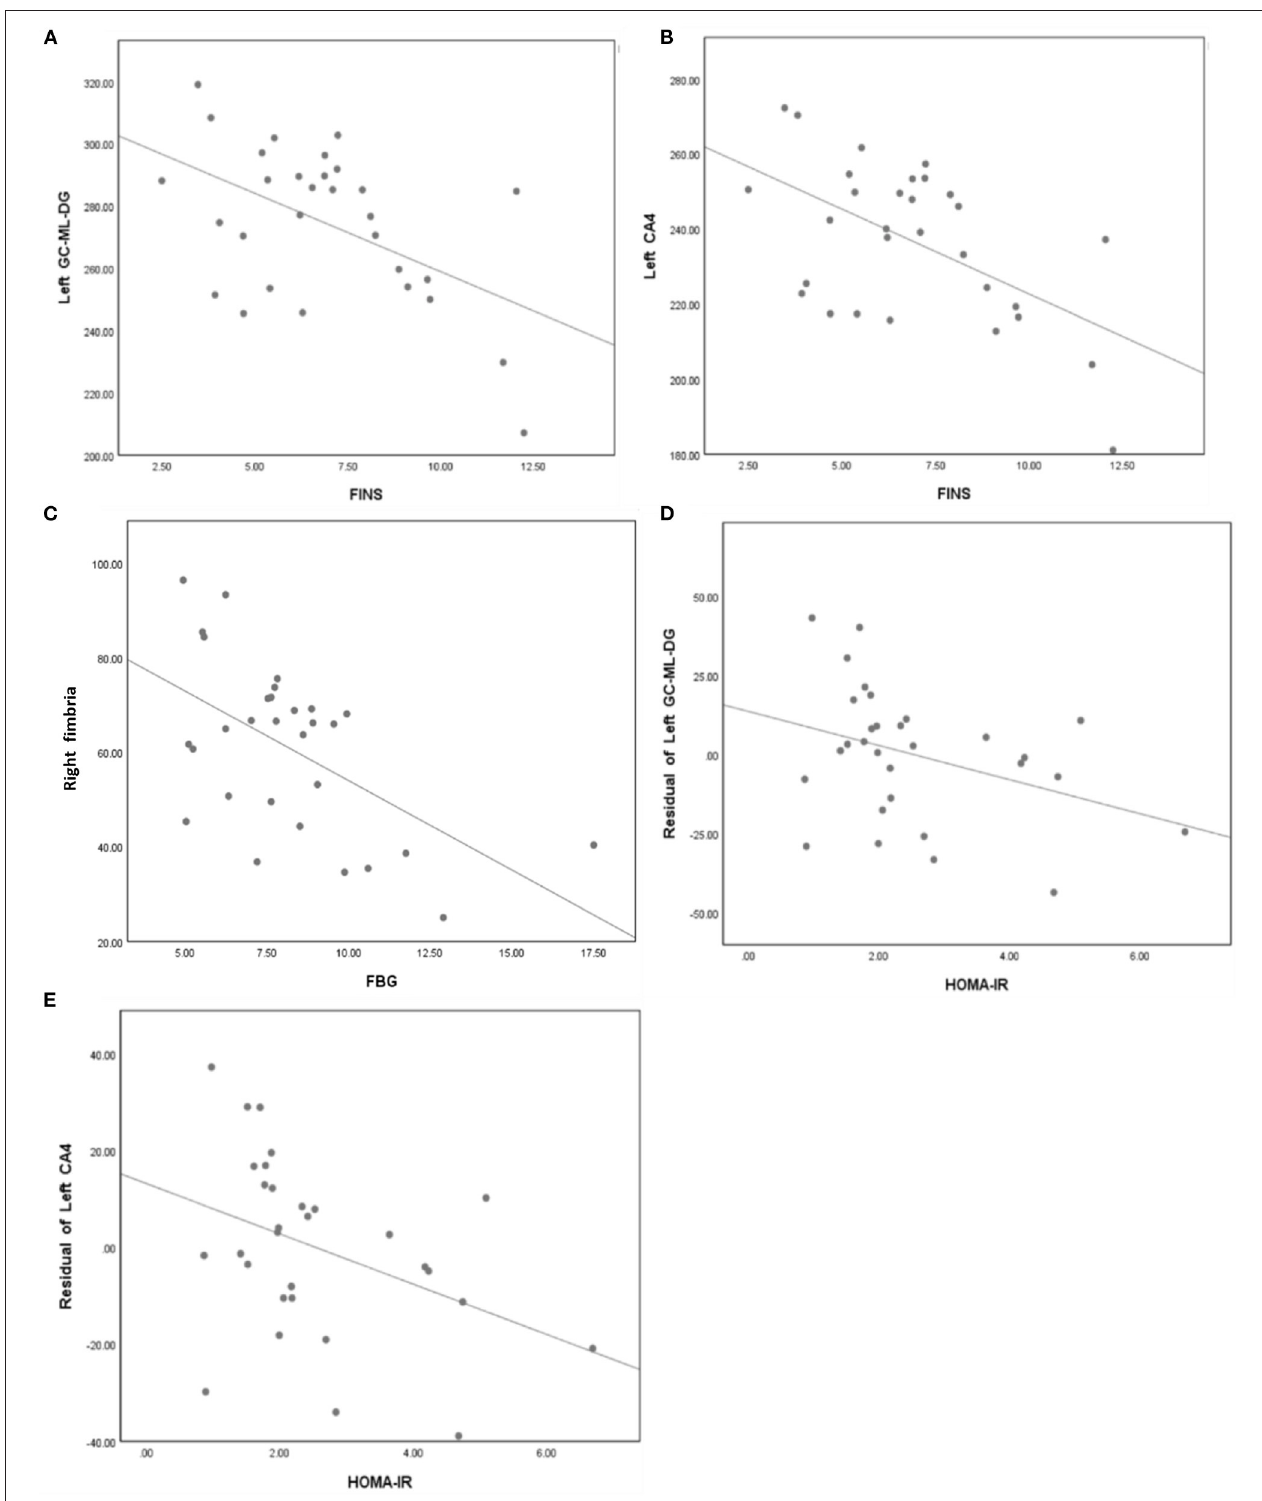
FIGURE 3 | (A) FINS was negatively correlated with volume of left GC-ML-DG ( r = − 0.415, p = 0.035). (B) FINS was negatively correlated with volume of left CA4 ( r = − 0.489, p = 0.011). (C) FBG was negatively correlated with volume of right fimbria ( r = − 0.460, p = 0.018). (D) HOMA-IR was negatively correlated with volume of left GC-ML-DG ( r = − 0.367, p = 0.046). (E) HOMA-IR was negatively correlated with volume of left CA4 ( r = − 0.462, p = 0.010).